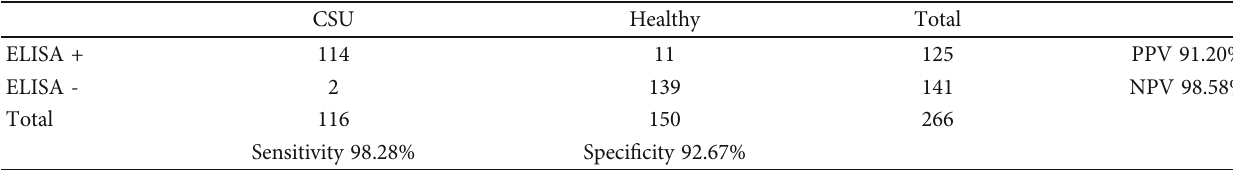
Table 3: Validation of cut-o ff value in the second